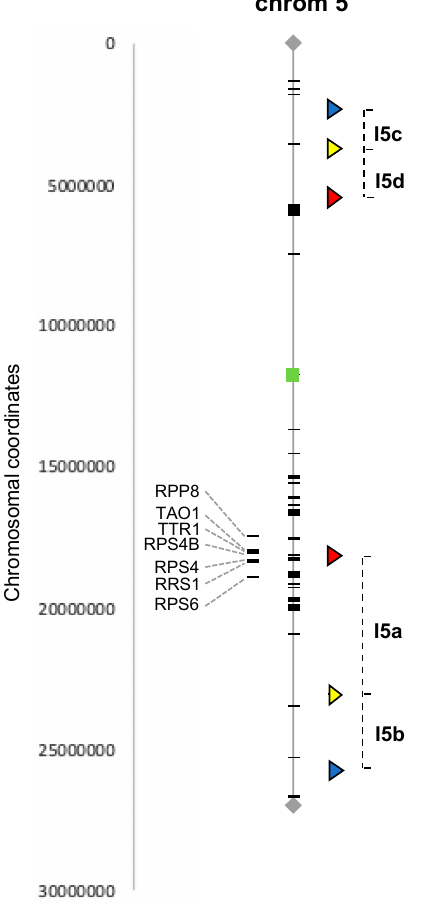
Figure 1. Distribution of NLR genes and Fluorescent Tags on the Arabidopsis chromosome 5. The chromosome with its centromere (green square) is delimited by the telomeres (black lozenge) at each end. The NLR encoded-genes (black dashes) are localized on the gray thin line of the chromosome or on the left side for NLR R genes with known biological functions. The Fluorescent Tags (triangle) and the intervals determining the Fluorescent Tagged Lines (FTL) I5ab and I5cd are indicated on the right side of the